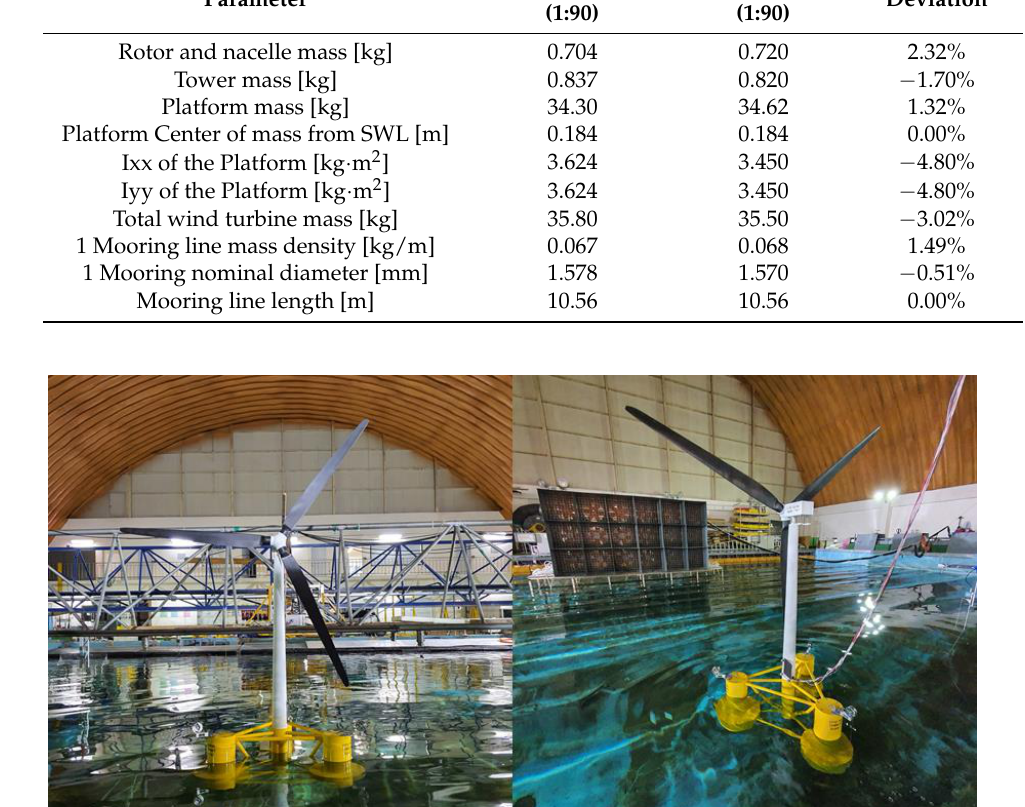
Figure 2. Installation view of test model.